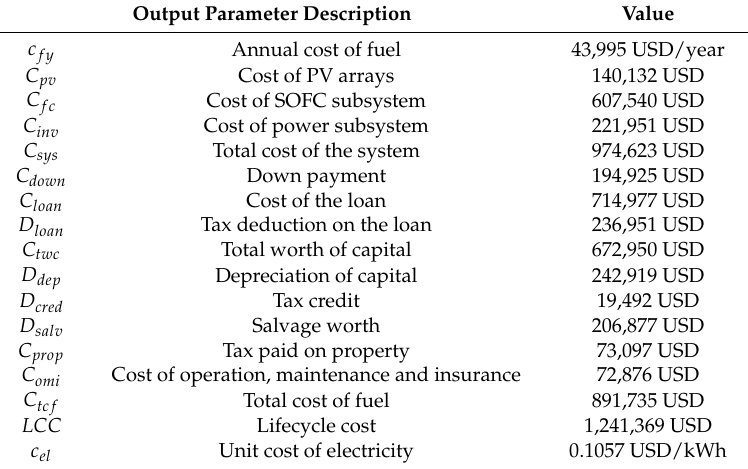
Table 6. Cost analysis of the proposed hybrid PV-SOFC